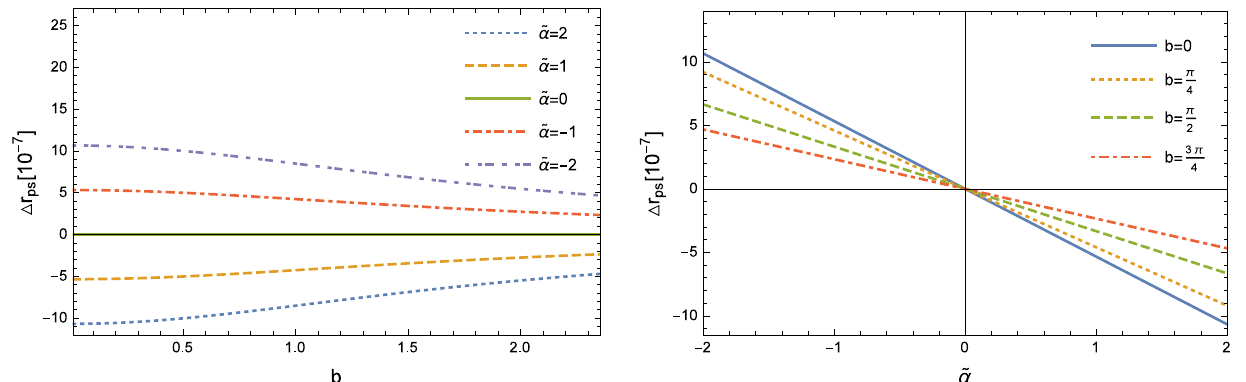
Fig. 1 Variation of the difference of photon sphere radius (cid:15) r ps with phantom hair b (left) and coupling constant (cid:12) α (right) in the regular phantom black